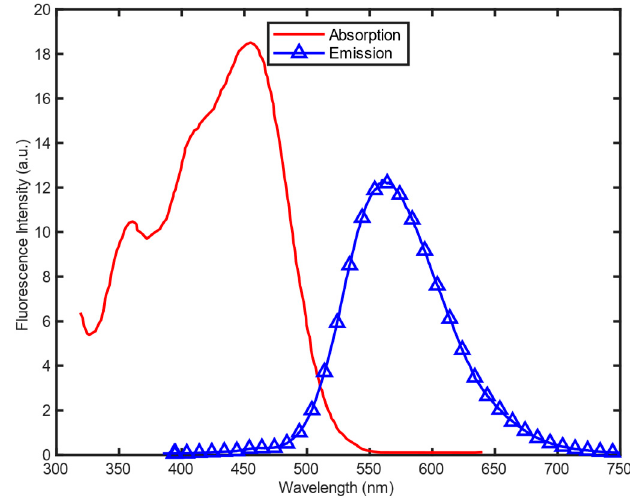
Figure 3. Absorption and emission spectra of V-carbazole.